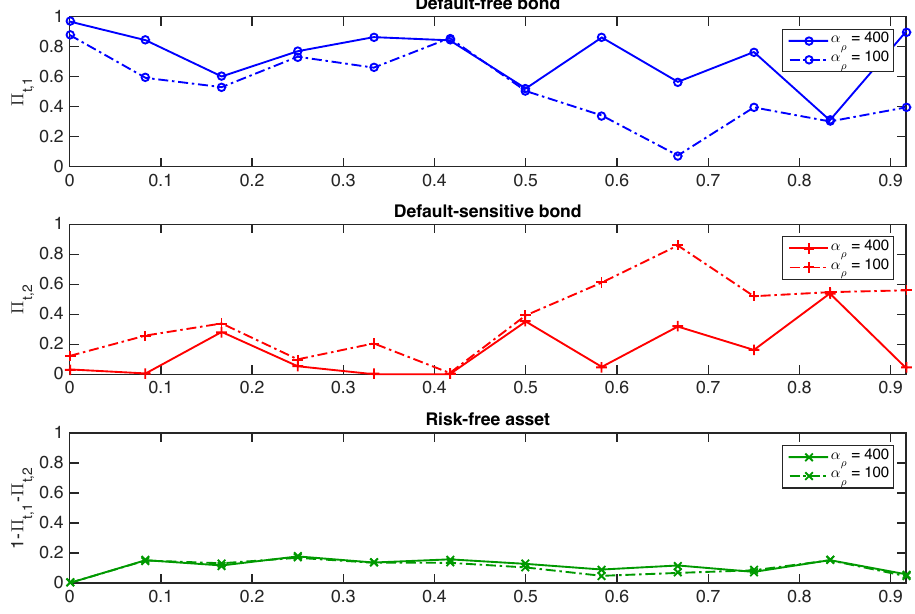
Figure A2. Sensitivity of optimal strategies to a change in α ρ